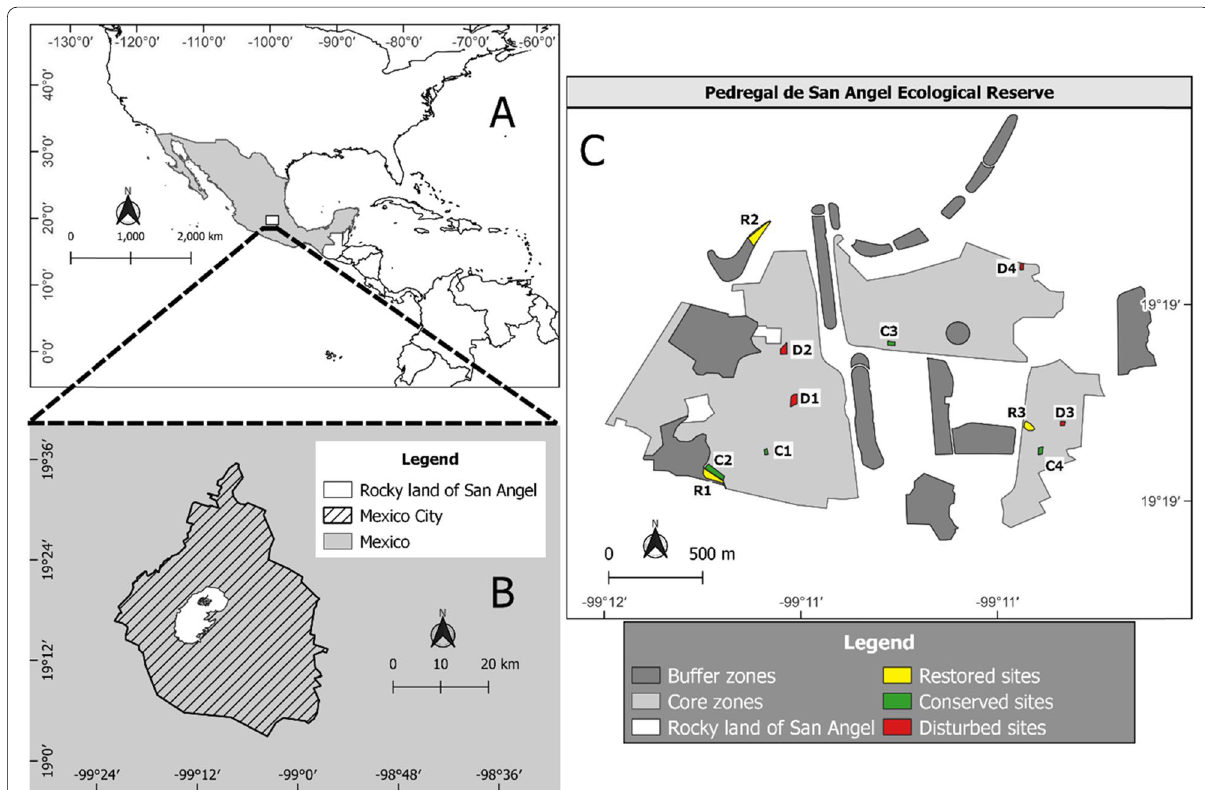
Fig. 1 A Location of the Pedregal de San Angel, in Mexico City. B Original extension of the Pedregal and location of the PSAER (2020), C Sampling sites in the PSAER, noted as white